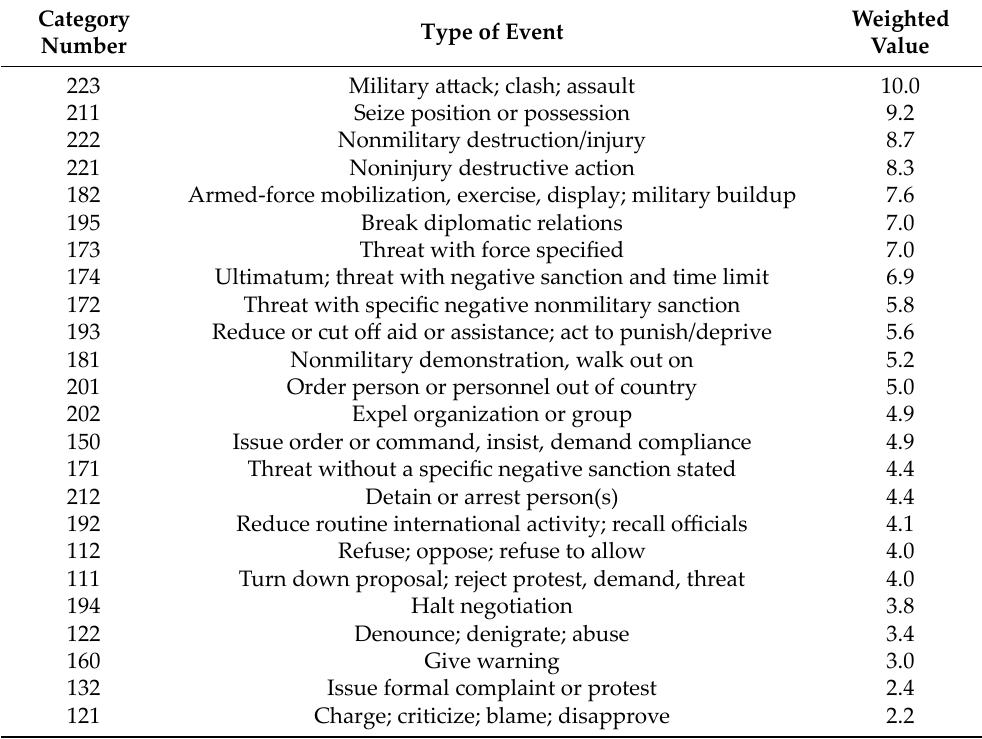
Table 1. Goldstein Scale for WEIS Project (Goldstein